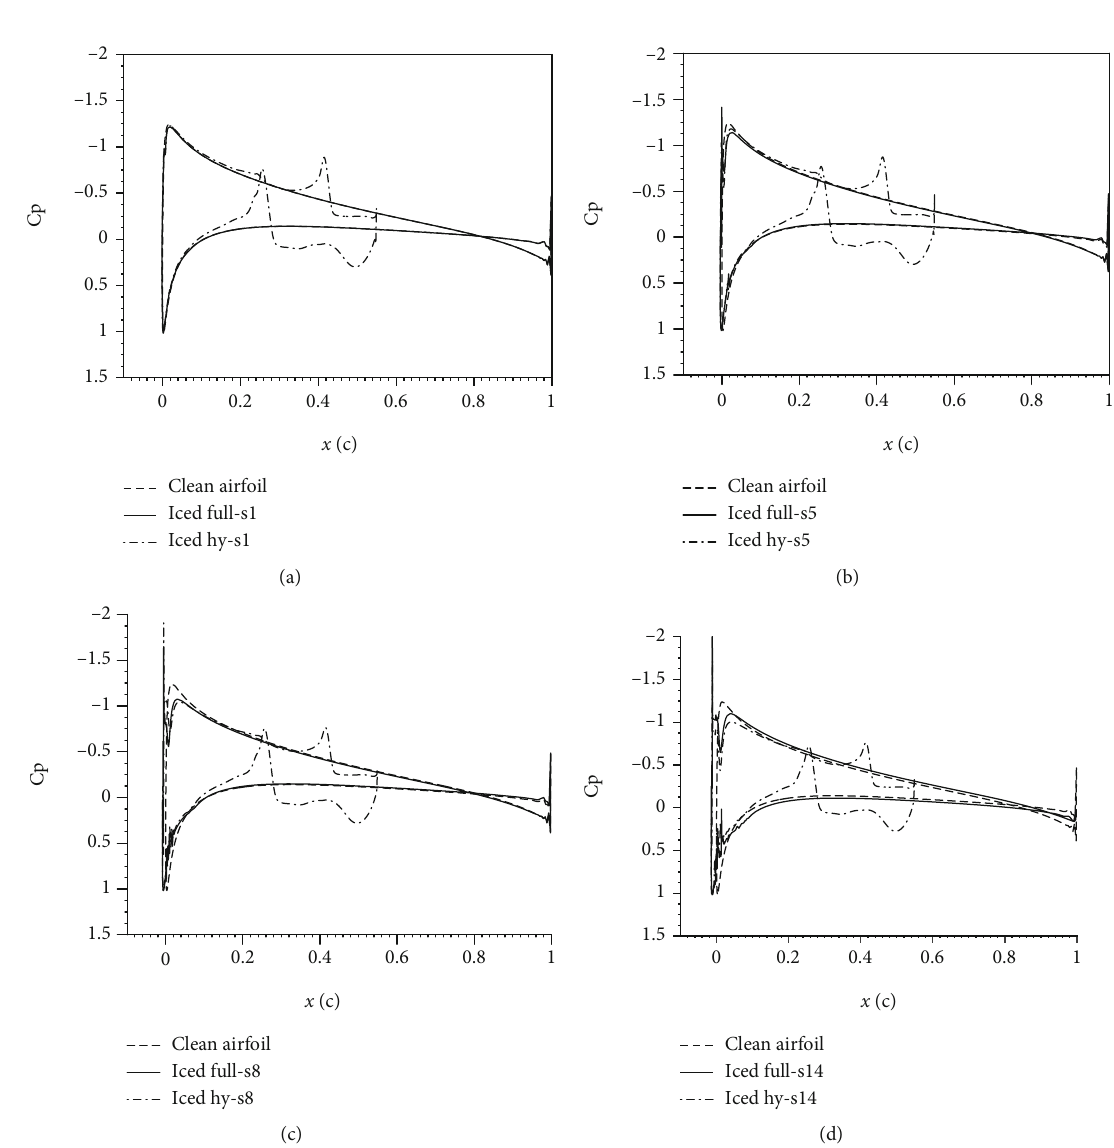
Figure 15: Comparison of Cp in icing process at (a) step 1 (30 s), (b) step 5 (150s), (c) step 8 (240s), and (d) step 14